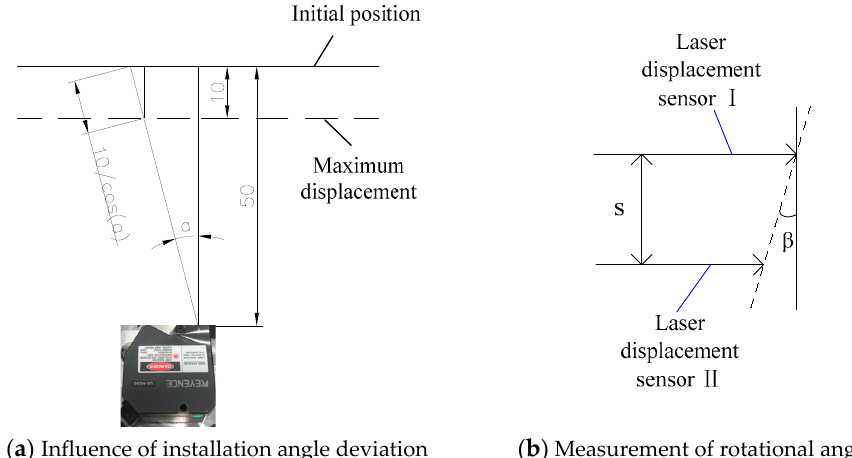
Figure 5. Influence of installation angle deviation on the measurement result and measurement of rotational angle.